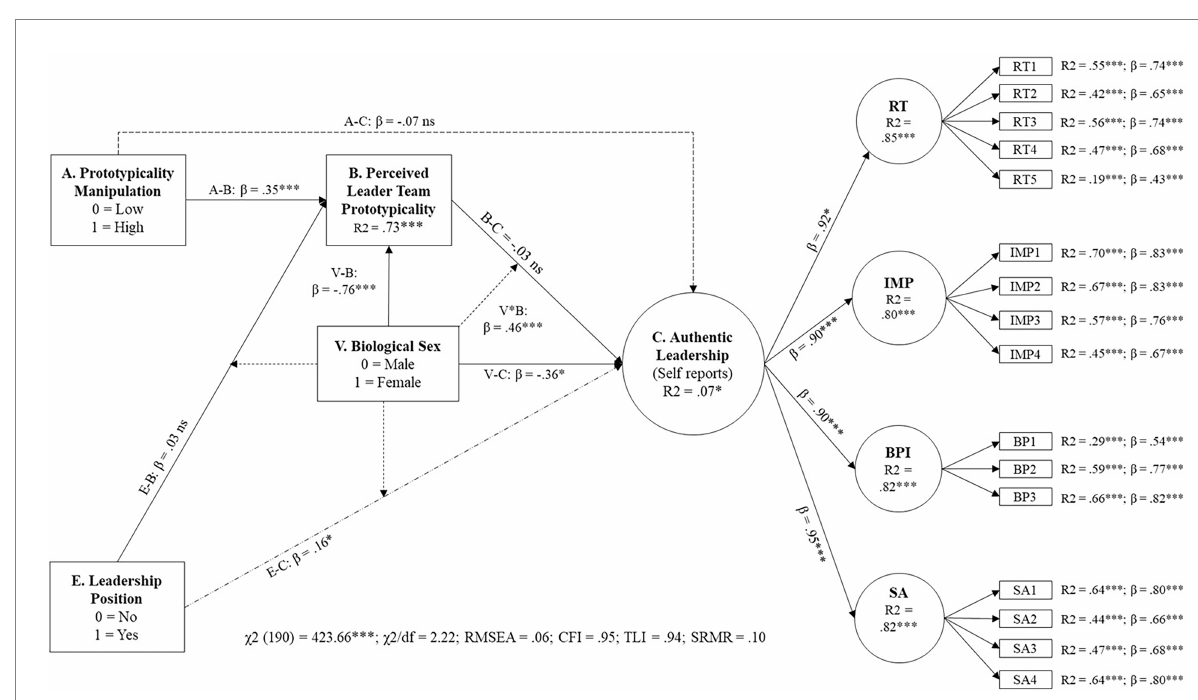
FIGURE 5 Study 1—Results of a SEM testing Hypotheses 1a, 2a, and H4a (self-perception